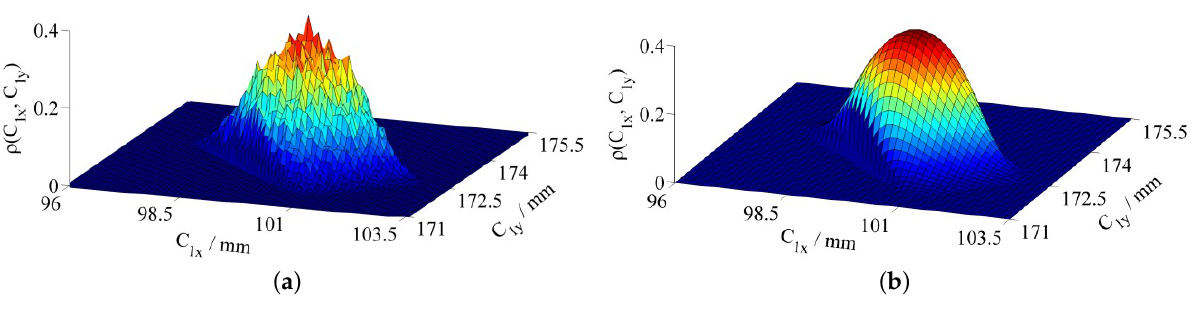
Figure 20. The PDF of Point C 1 . ( a ) Simulation result. ( b ) Theoretical